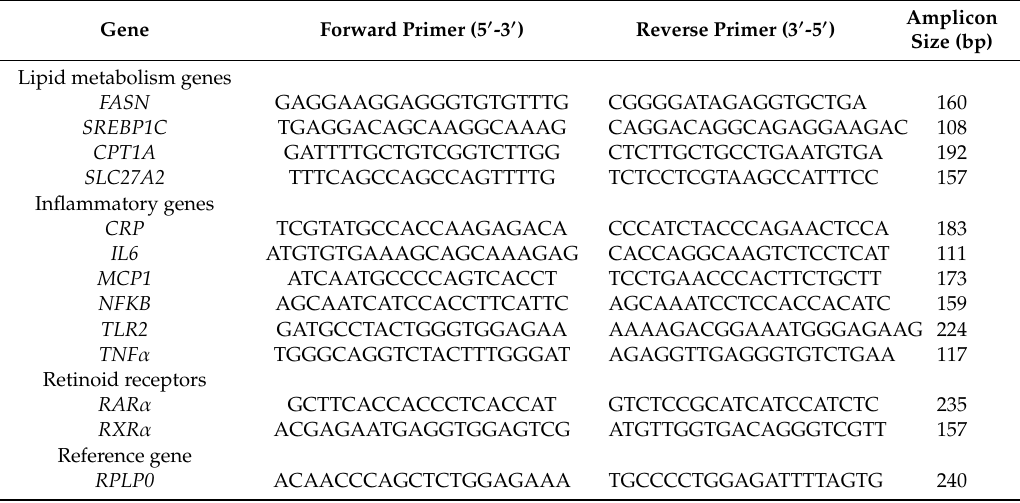
Table 1. Nucleotide sequences of primers and amplicon size used for real-time RT-qPCR amplification in human peripheral blood mononuclear cells